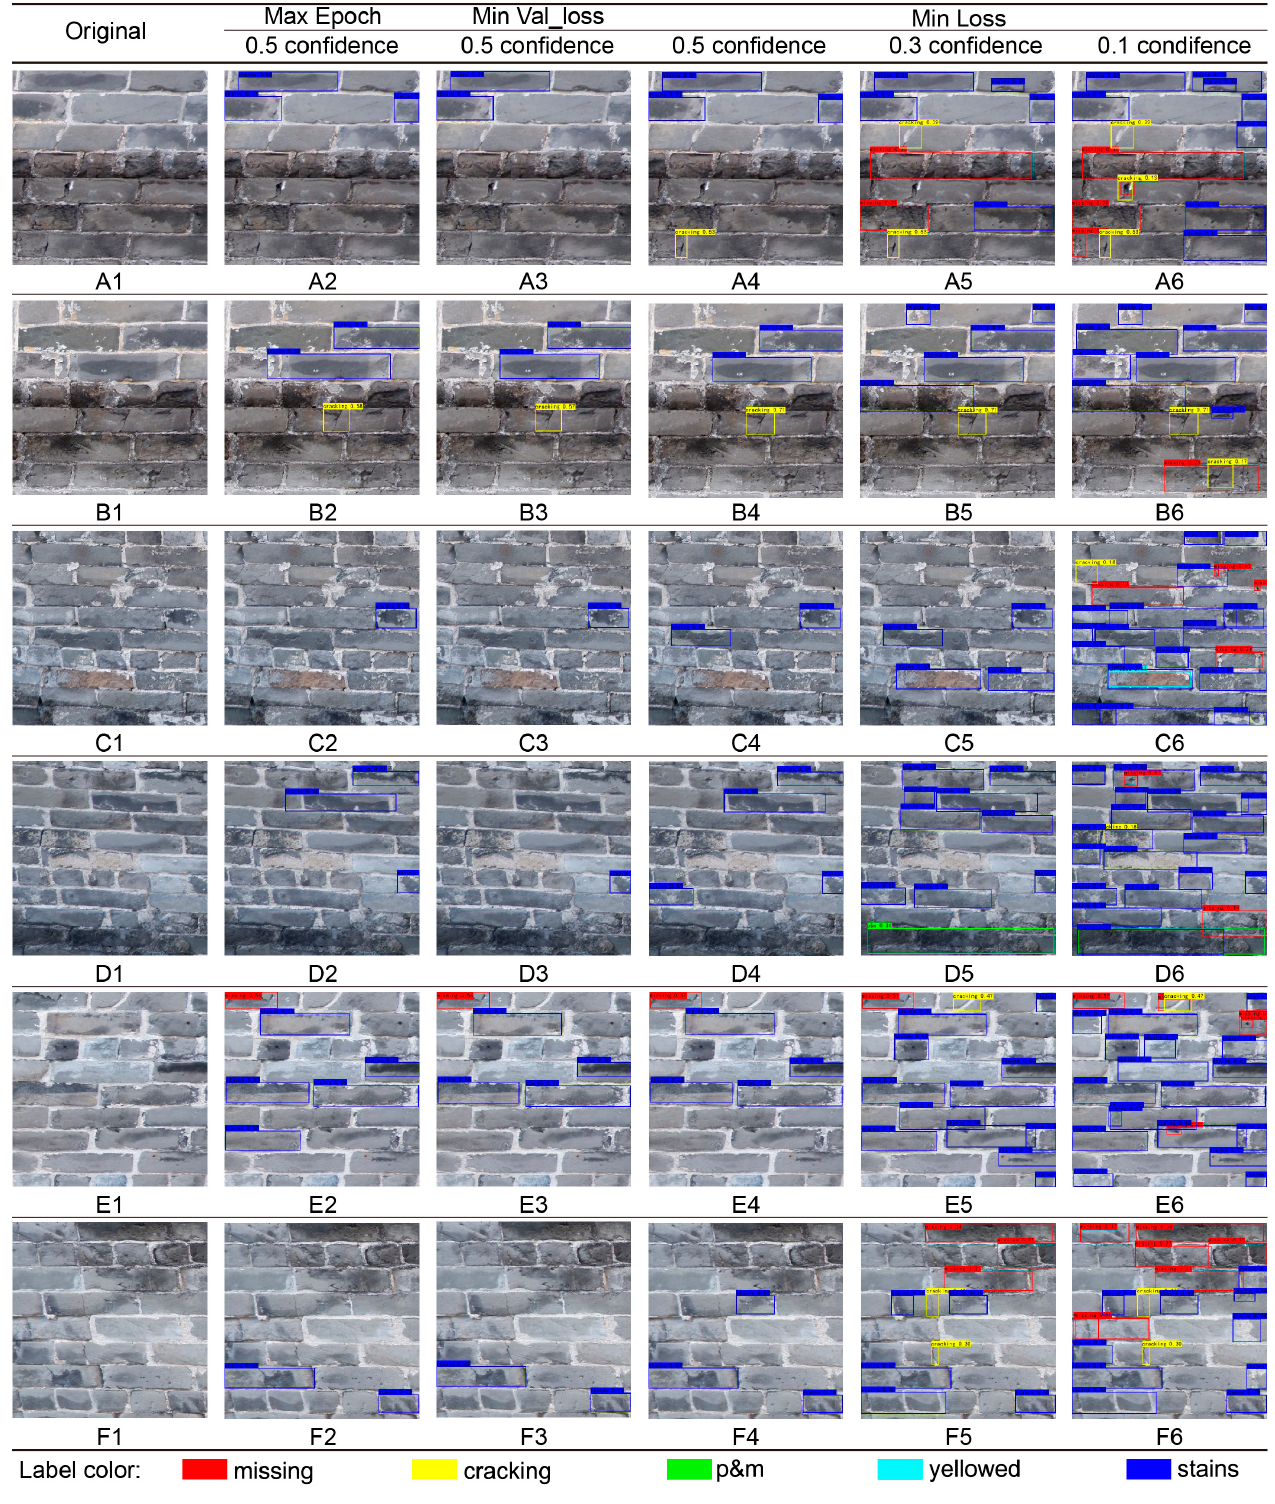
Figure 9. The results of different weight file tests. The samples for the test are randomly selected from 1000 training set samples, named A to F, and different weight files are loaded into the model to output the results. (Image Source: drawn by the author).